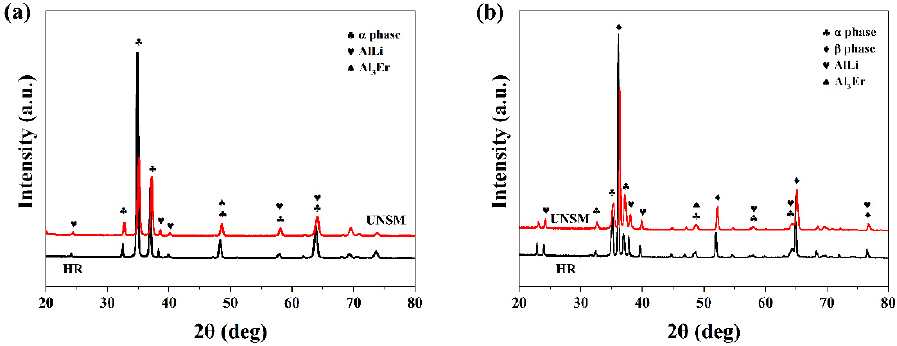
Figure 3. XRD patterns of LAE361 Mg-Li alloy ( a ) and LA106 Mg-Li alloy ( b ) before and after the UNSM treatment. UNSM treatment.